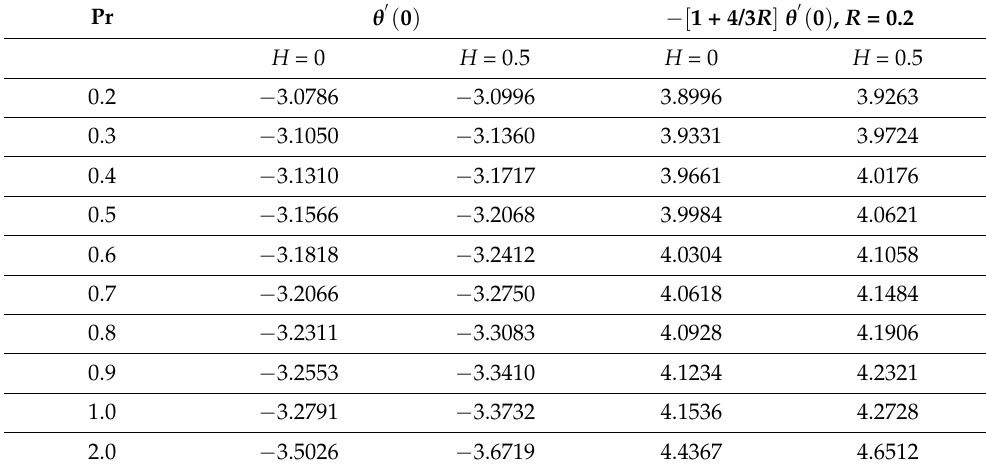
Table 19. Impact of Prandtl number on Nusselt number with and without heat generation.